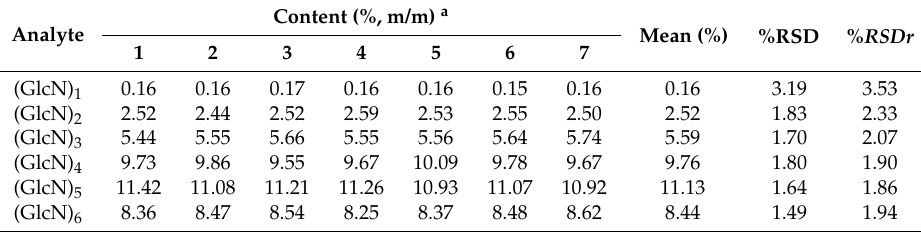
Table 3. Determination of each chitooligosaccharides (COS) in COS technical concentrate containing (GlcN) 1–6 . Analyte